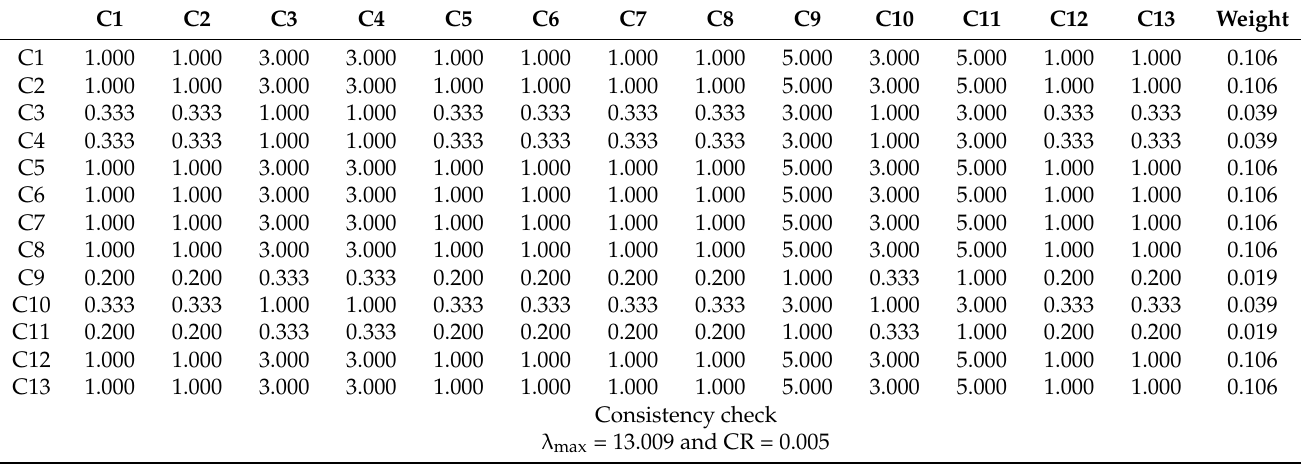
Table 8. Matrix of comparisons, criteria weights, and consistency assessment estimated using the classical AHP method.